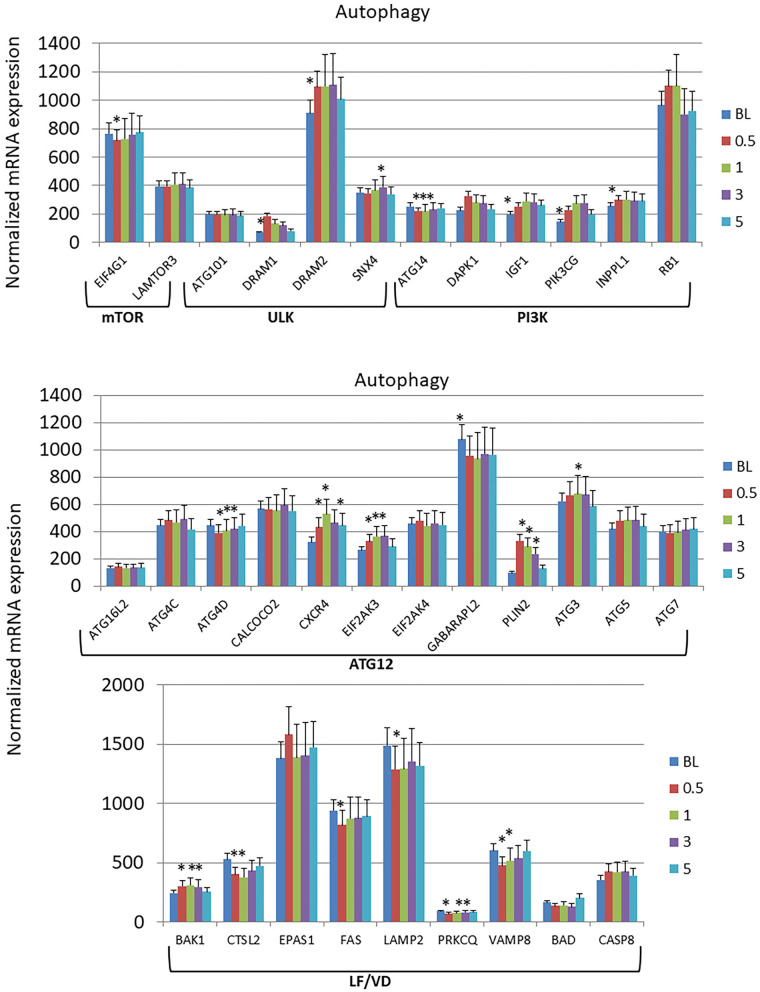
Expression levels of autophagy genes in gingival samples at baseline (BL) and 0.5, 1, and 3 months following ligation. Five month samples represent 60 days following removal of the ligatures with resolution of the clinical features of the disease. The genes are grouped into various categories representing steps in the autophagy pathway. The bars denote the means of 18 animal samples and the vertical bracket signifies one SD. The asterisk (*) denotes significantly different from baseline levels or baseline levels being different from all other time points at p < 0.05.